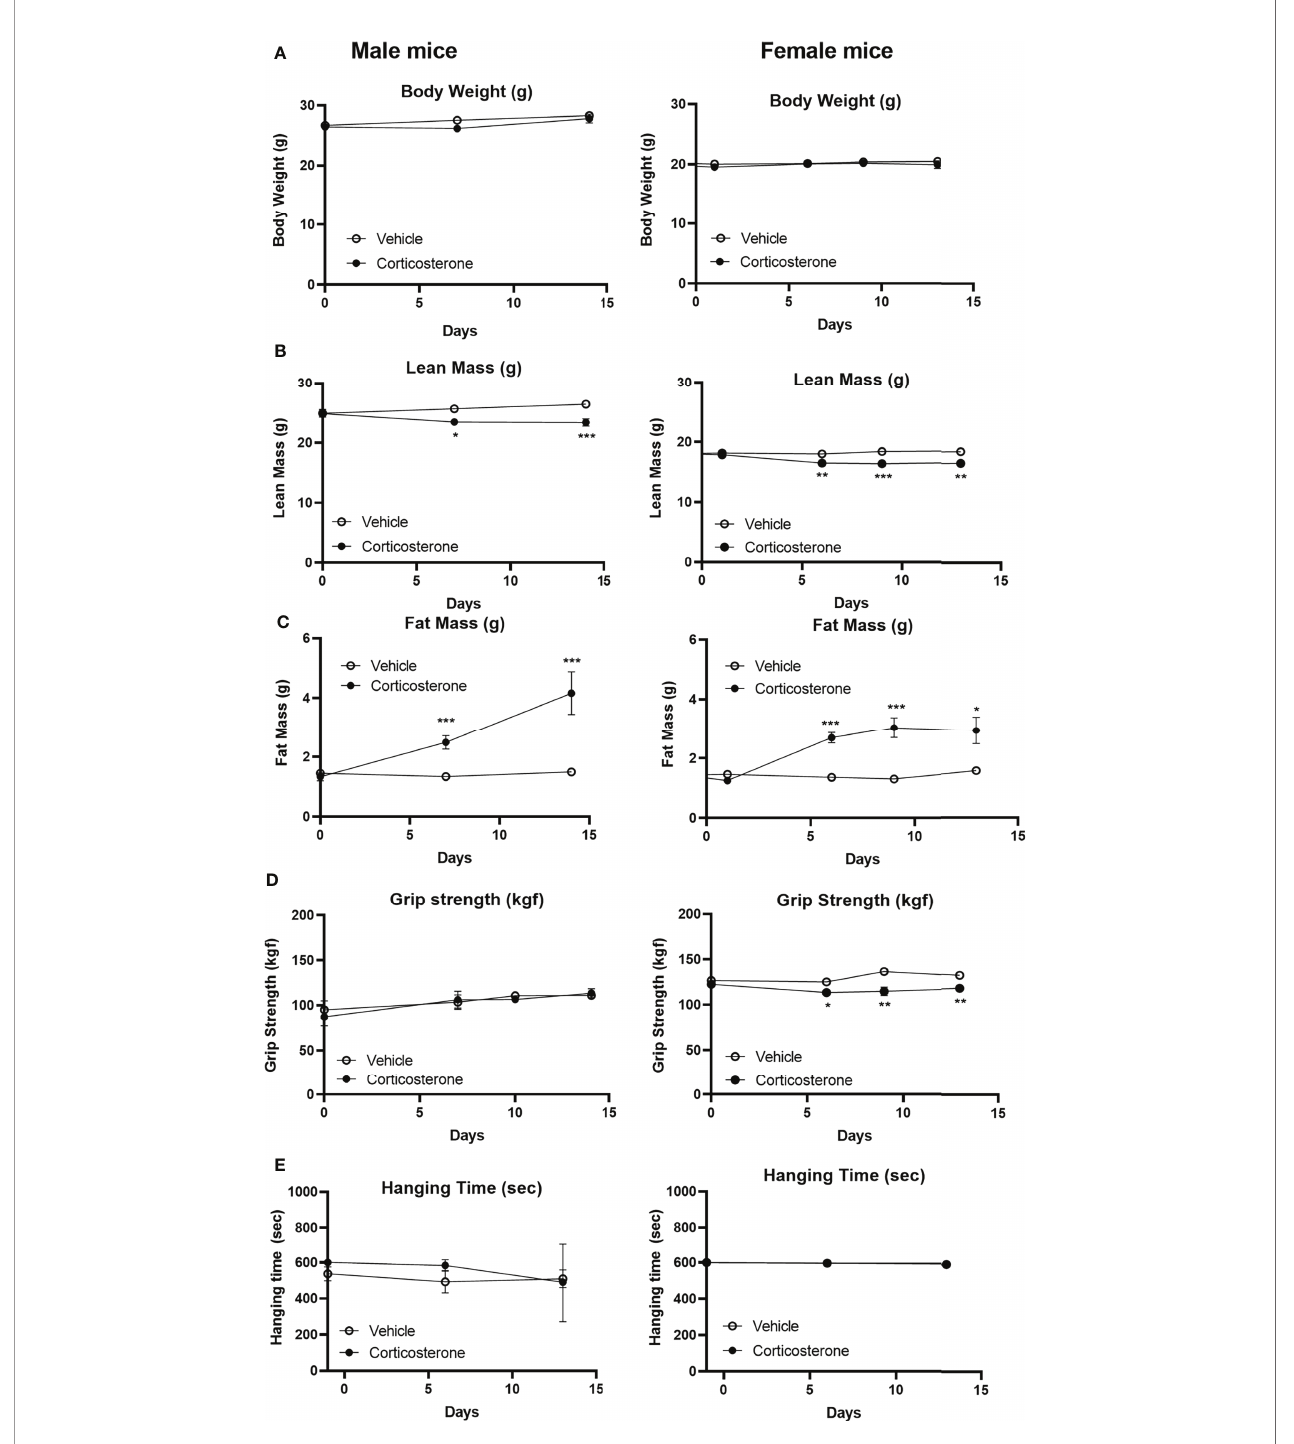
FIGURE 1 | Corticosterone treatment speci fi cally decreases muscle function in female mice. The effect of corticosterone treatment on (A) total body mass, (B) lean mass, (C) fat mass, (D) fore limb grip strength and (E) grid hanging in male and female C57BL/6J mice. N=8 mice/group. *p<0.05 vs. Vehicle, **p<0.01 vs. Vehicle, ***p<0.001 vs. Vehicle. Statistical signi fi cance was calculated using a two-way ANOVA.